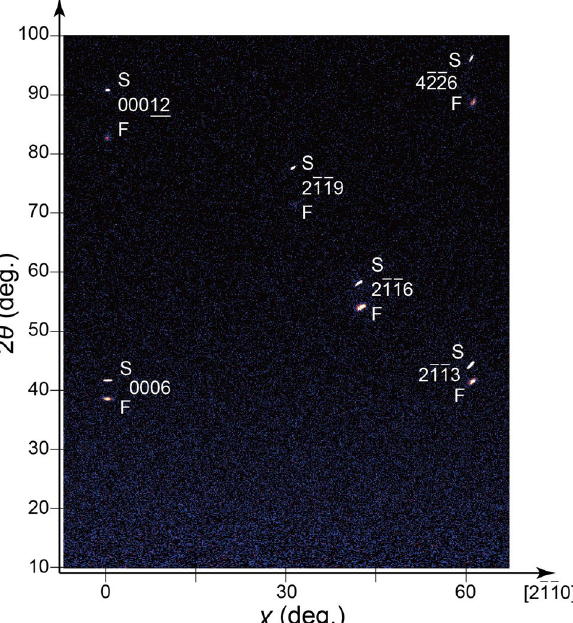
Figure 2. Identical crystal structure for the LT-Ti 2 O 3 film and α -Al 2 O 3 substrate. 2D XRD contour map of the LT-Ti 2 O 3 film on α -Al 2 O 3 (0001) substrates. The labels F and S denote the reflections from the LT-Ti 2 O 3 film and α -Al 2 O 3 substrate, respectively. The tilt angle χ = 0° corresponds to out-of-plane directions. The azimuthal angle φ is fixed along [2-1-10]